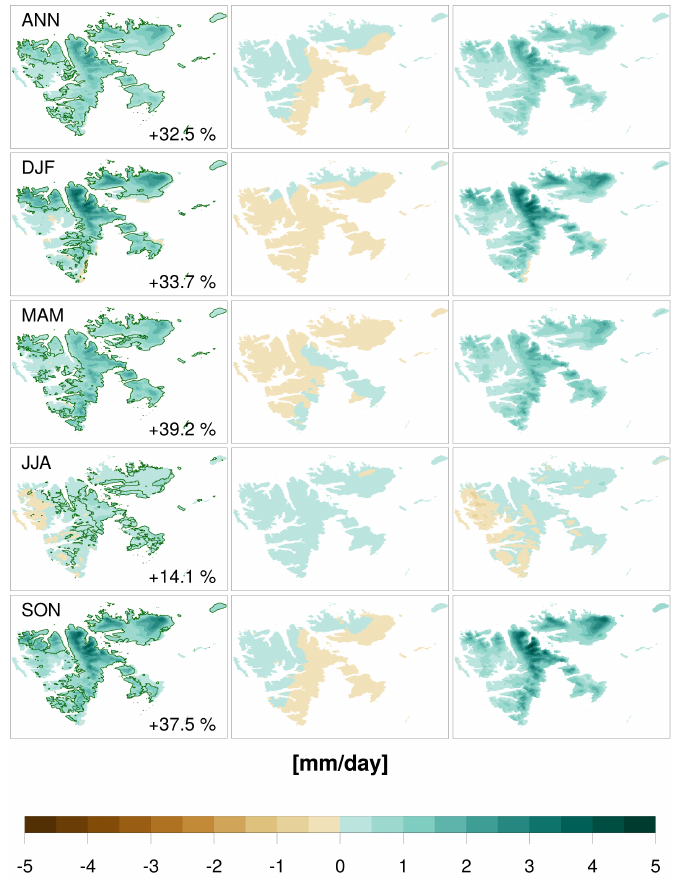
Figure 12. Changes in precipitation (from 1971–2000 to 2071–2100) decomposed into the contributions from frequency and large-scale condition changes. ( Left ): Changes in the annual (top) and seasonal mean precipitation climate projections over Svalbard. Statistically significant changes are outlined. ( Center ): Precipitation changes resulting from frequency changes only. ( Right ): Differences resulting from large-scale condition changes